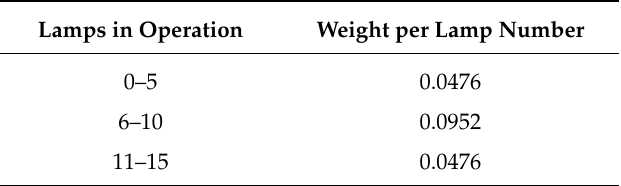
Table 4. Weighted distributions to determine the number of operating